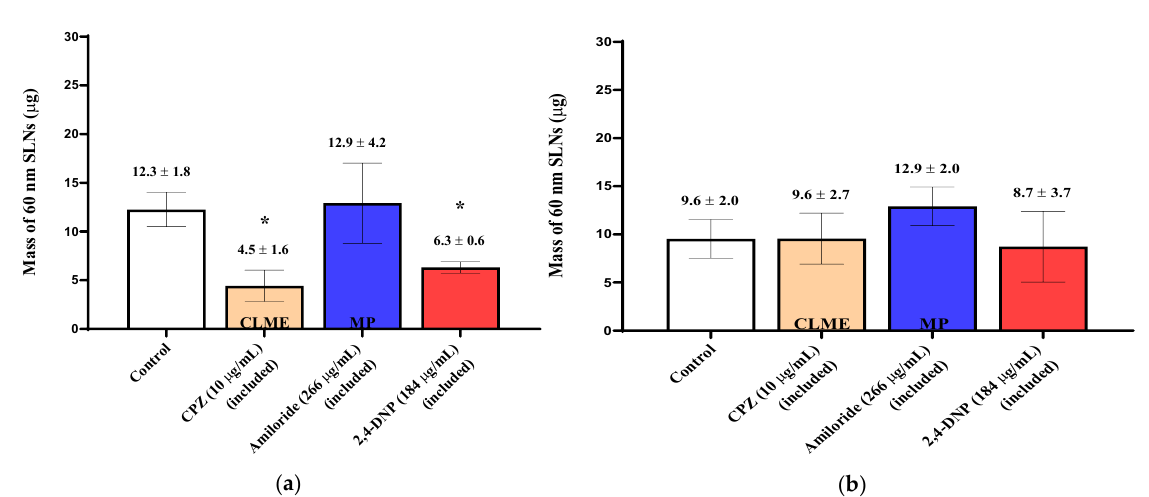
Figure 3. Uptake (30 min) of 60 nm SLNs in the nasal olfactory ( a ) and respiratory ( b ) tissues in the presence of endocytic inhibitors. Bar graphs display mean nanoparticle uptake ± standard deviation determined from the recovery of Nile Red from the tissues. Statistical comparisons were made between each of the inhibited tissues and the control tissues using Student’s two tailed t -test ( p < 0.05). * denotes a significant statistical difference between the inhibited and control tissues.